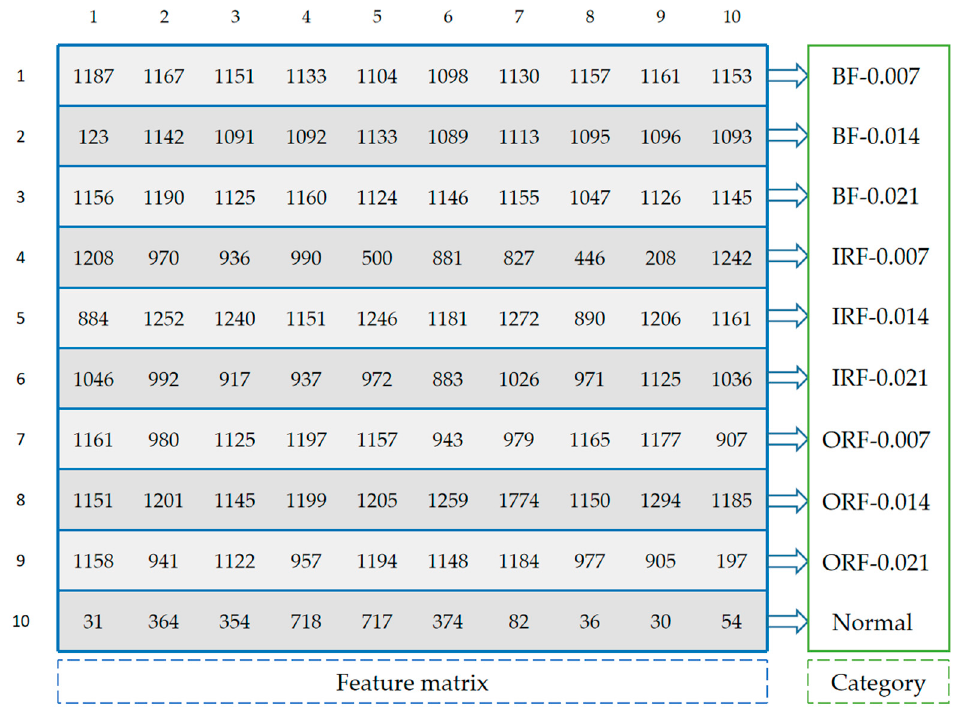
Figure 8. Diagnosis results of FDFM algorithm under different SNRs when the number of sampling points is 1024, 2048 and 4096 respectively.